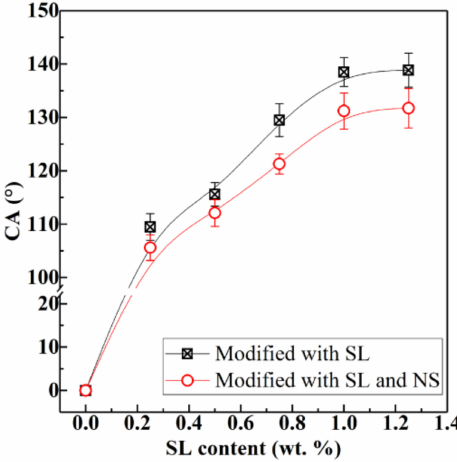
Figure 2. Influence of SL concentration on the surface contact angle (CA) of pure hardened cement pastes (HCPs) and NS-modified HCPs; the content of NS in the HCP is 0 wt.% (HCP) and 1.0 wt.% (NS-modified HCPs or HCPNS),